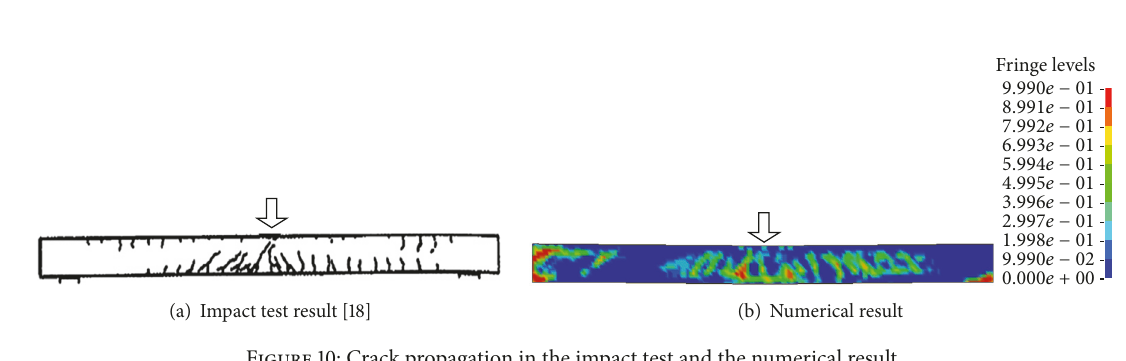
Figure 10: Crack propagation in the impact test and the numerical result.